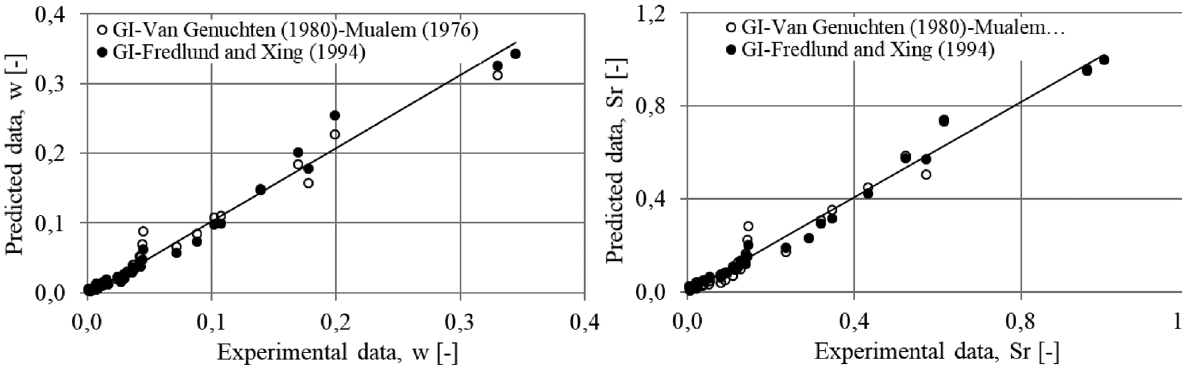
Figure 10: Veri fi cation of experimental with predicted data of SWCC: ( left ) gravimetric water content ( w ) results and ( right ) degree of saturation ( Sr ) results for GI soil.